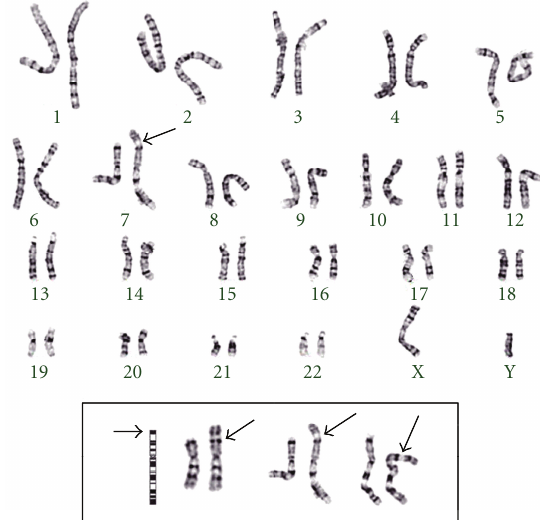
Figure 1: Patient’s complete and partial (boxed, di ff erent band resolutions) GPG-banded karyograms, displays extraneous chro- mosomal material at the telomere of chromosome 7p.